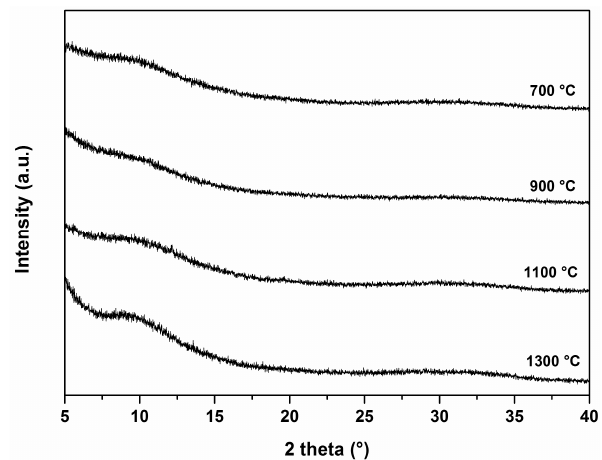
Figure 3. Diffraction patterns of SiCaMgOC glass pyrolyzed at 700, 900, 1100, and 1300 °C.